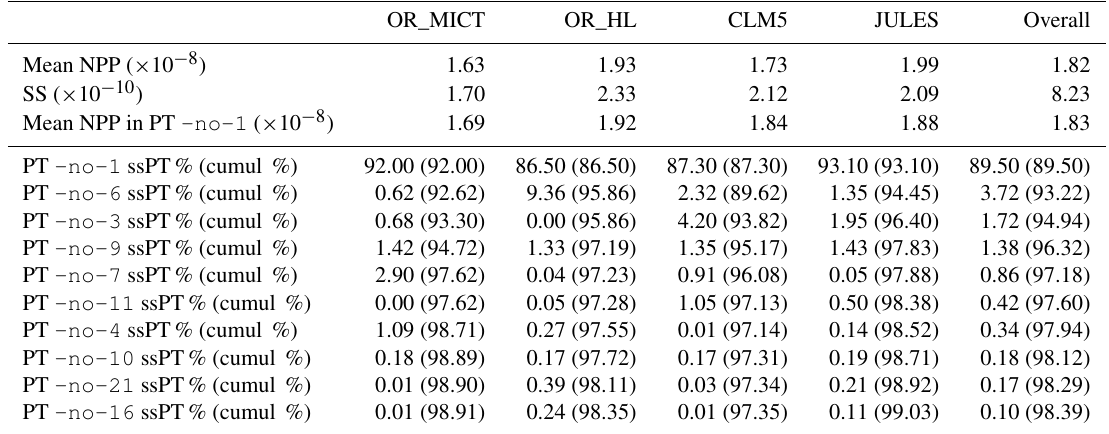
Table 2. Mean NPP (kgm − 2 s − 1 ) and sum of squares of NPP (SS) for the original aggregated and individual LSMs, together with the SS explained by each PT from the PTA3 analysis, and the cumulative approximations (in brackets) to the overall SS and the SS of each LSM.